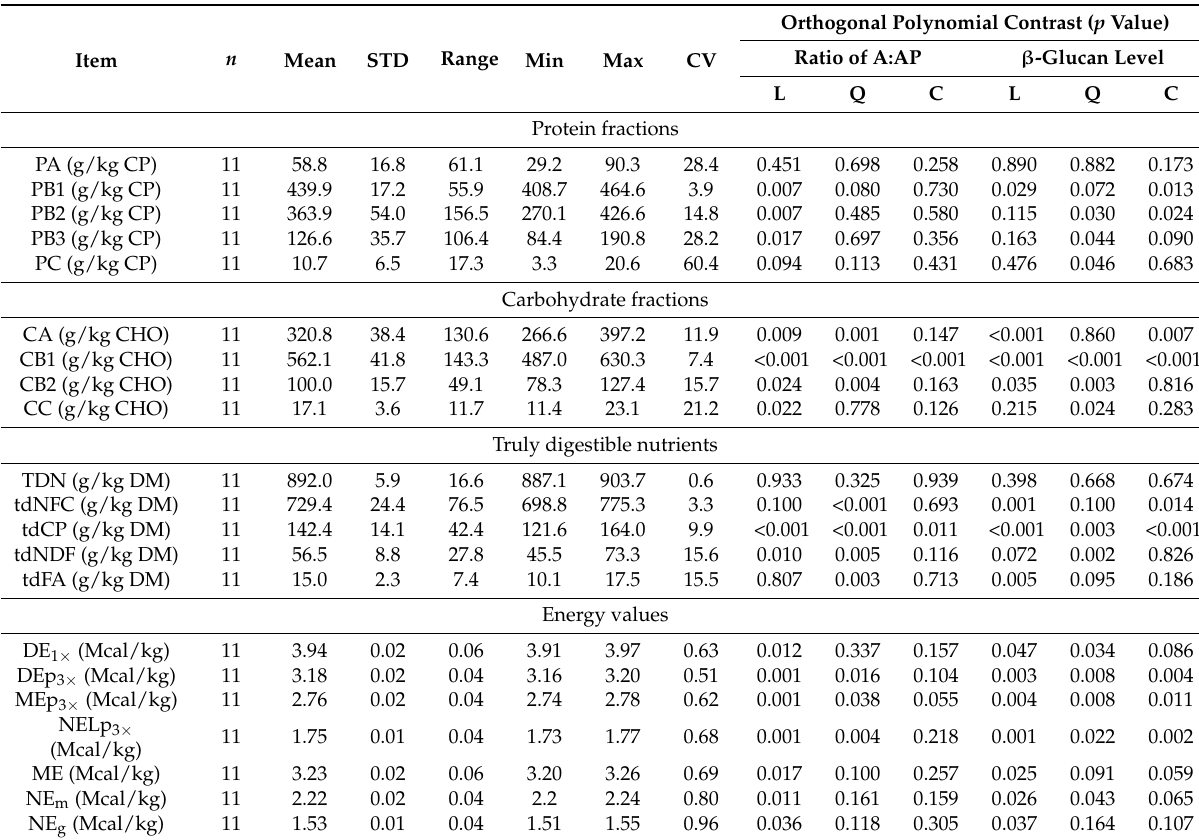
Table 2. Curve-linear response of protein and CHO fractions partitioned by using the Cornell Net Carbohydrate and Protein System (CNCPS), and energy values to altered CHO macromolecular structure traits in CDC hulless barley